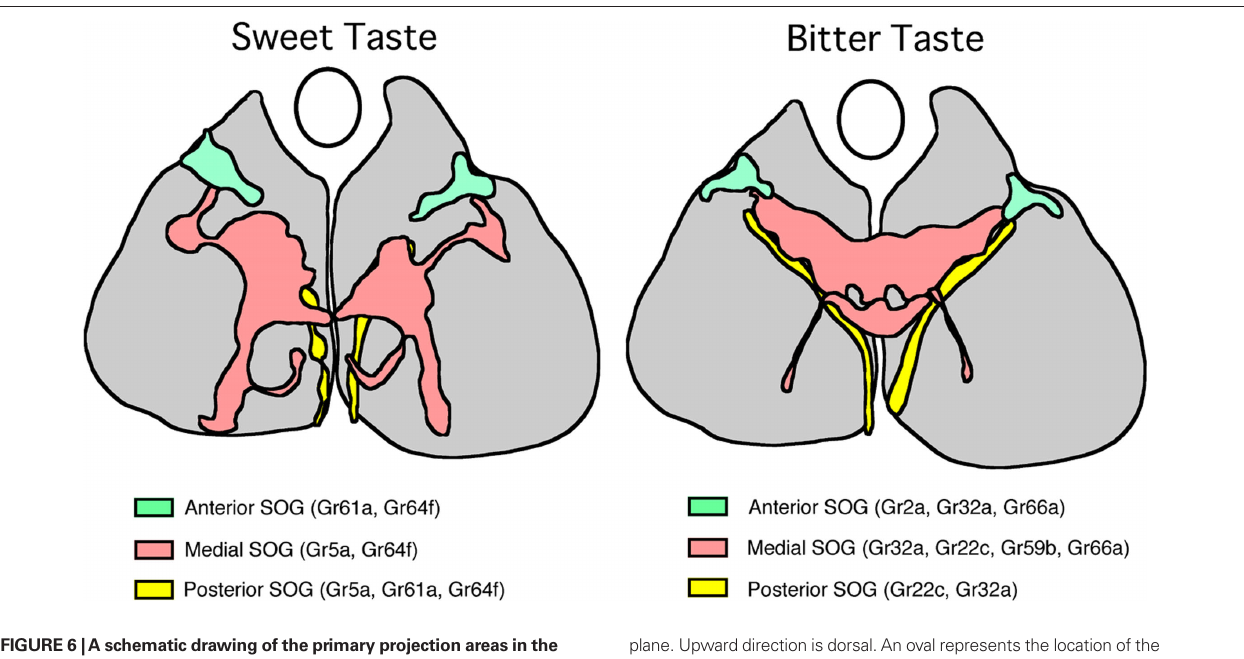
FiGuRe 6 | A schematic drawing of the primary projection areas in the subesophageal ganglion (SOG) of sugar taste neurons (left) and bitter taste neurons (right). Frontal views of the anterior (blue), medial (pink) and posterior (yellow) projection areas in the SOG are superimposed in the same